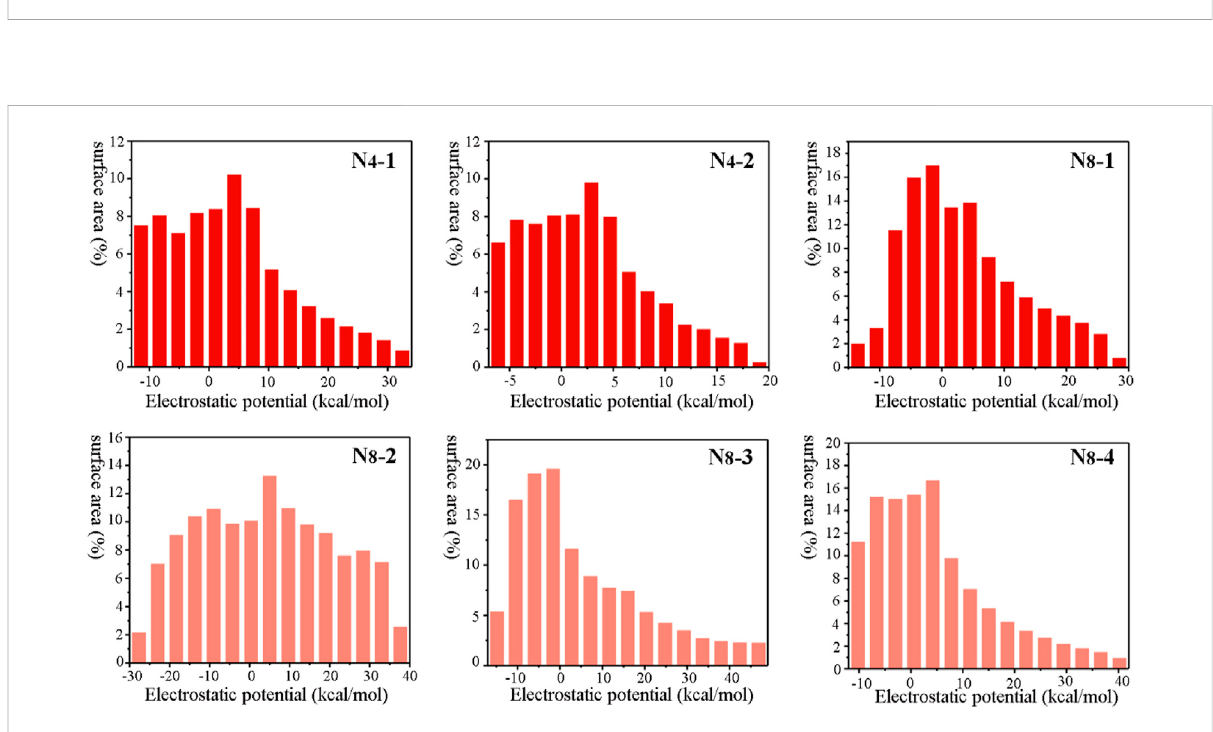
FIGURE 3 Molecular surface area of N 4 -1, N 4 -2, N 8 -1, N 8 -2, N 8 -3, and N 8 -4 ,